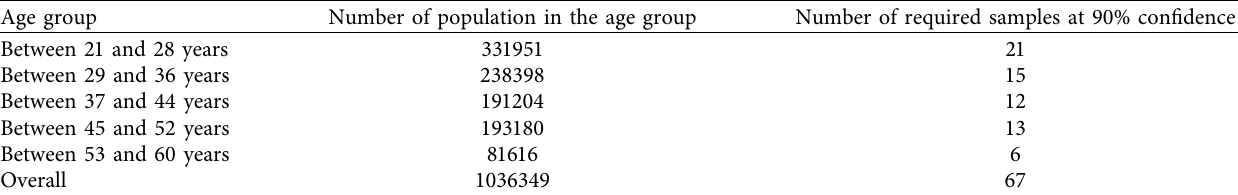
Figure 1: Structural equation model for analyzing driver-level model [4]. Table 1: Required sample size estimation based on age and gender